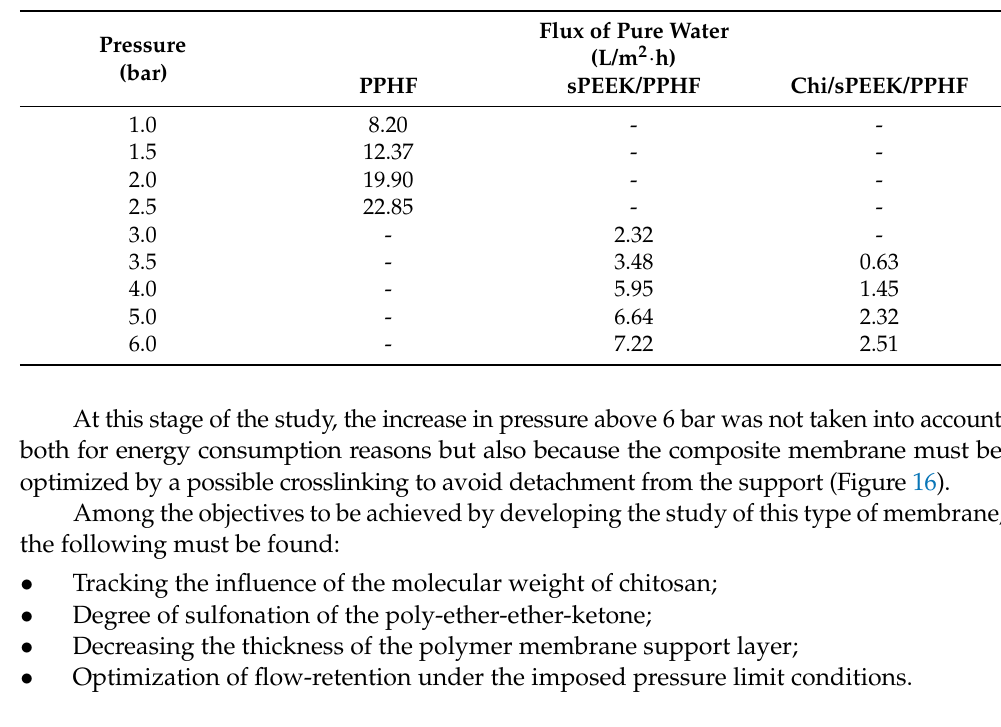
Table 5. Transmembrane water flows for the studied